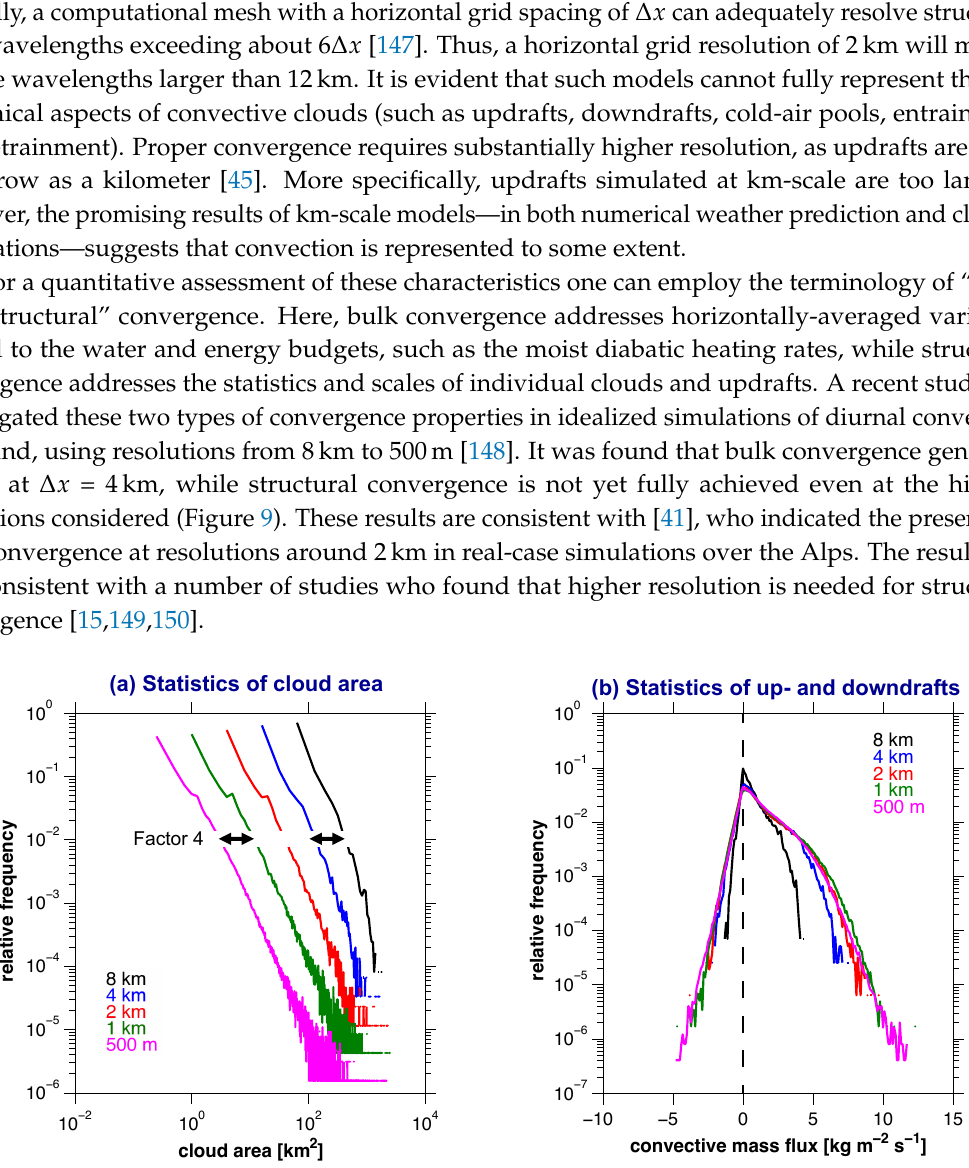
Figure 9. Comparison of ( a ) structural convergence and ( b ) bulk convergence for an idealized simulation of diurnal convection over land, for grid spacings from 8 km to 500m. ( a ) For the resolutions considered, structural convergence is not yet achieved, as the average cloud area reduces by a factor 4 when the grid spacing is reduced by a factor 2. ( b ) However, bulk convergence is achieved near ∆ x = 4 km, as demonstrated by the grid-point statistics of convective mass flux (from Panosetti et al.